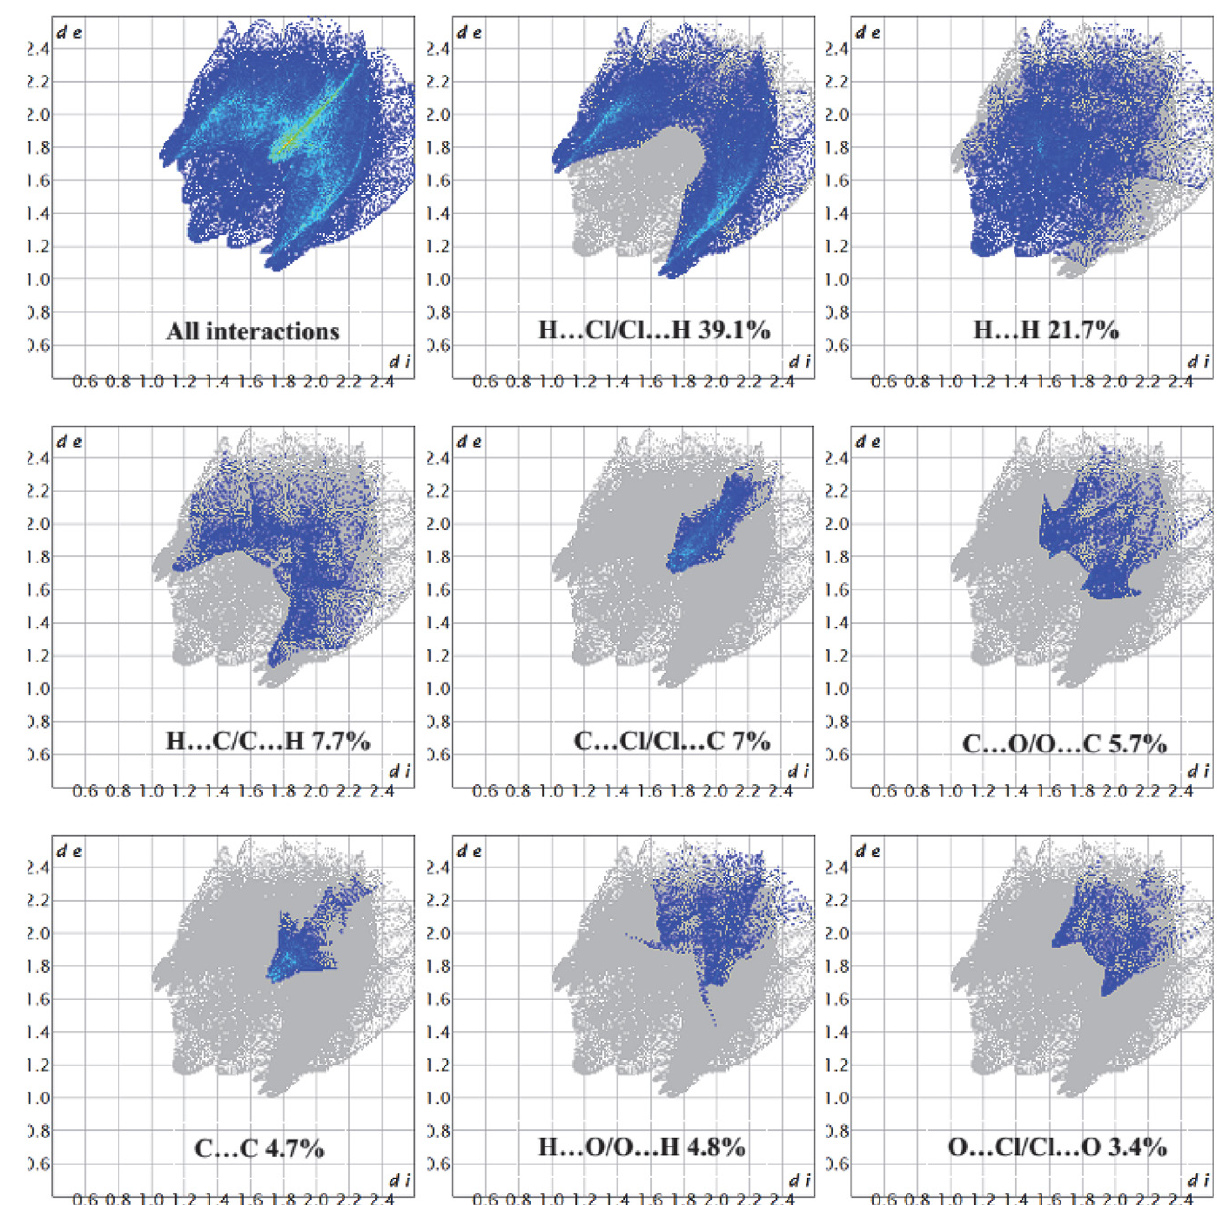
Figure 4: Fingerprint plots for the zinc(II) complex show the percentages of major contacts contributed to the total Hirshfeld surface analysis